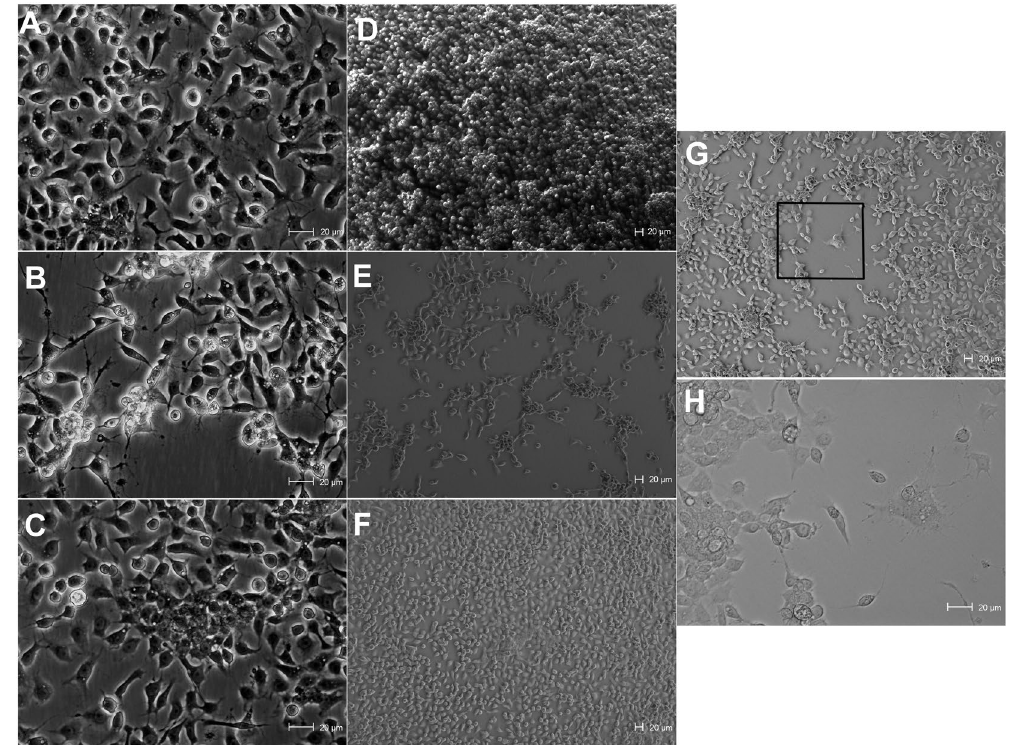
Figure 1. Optical microscopy of Ae . albopictus (C6/36) cell cultures infected by Mayaro or DENV. Uninfected C6/36 cells ( A ), MAYV-infected C6/36 cells ( B ), DENV-1-infected C6/36 cells ( C ). Cells were cultured in flasks and evaluated directly under optical microscopy without any preparation. These images were taken at 4 days post-infection (original magnification = 320x). Uninfected C6/36 cells ( D ), MAYV-infected C6/36 cells ( E ), DENV-1-infected C6/36 cells ( F ), these images were taken at 6 days post-infection (magnification = 100x). MAYV-infected C6/36 cells at 5 days post-infection (magnification = 100x) ( G ) the rare cytopathic effect caused by MAYV and ( H ) highlight for the cytopathic effect (magnification =